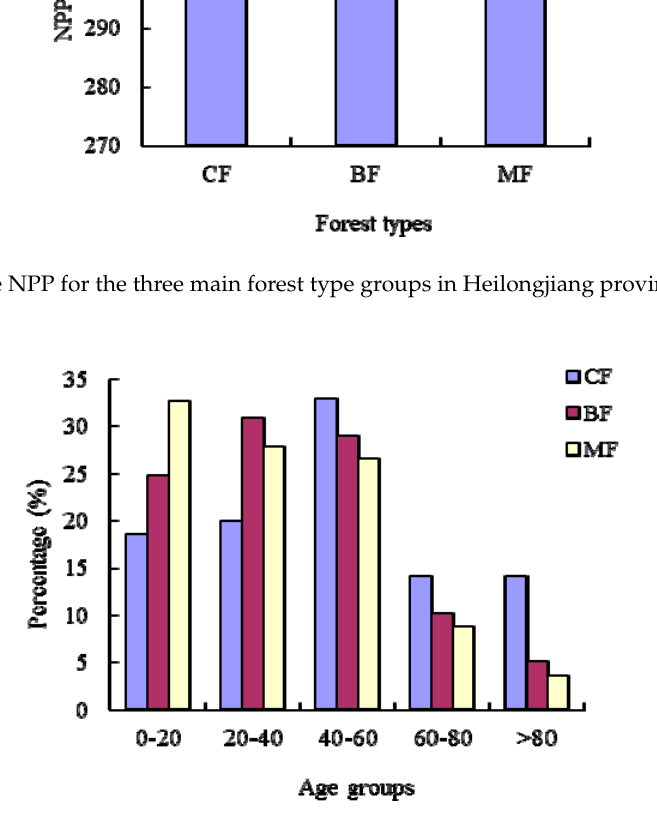
Figure 8. Pixel percentage for each stand age group for the three main forest type groups in Heilongjiang Province, China in 2010.